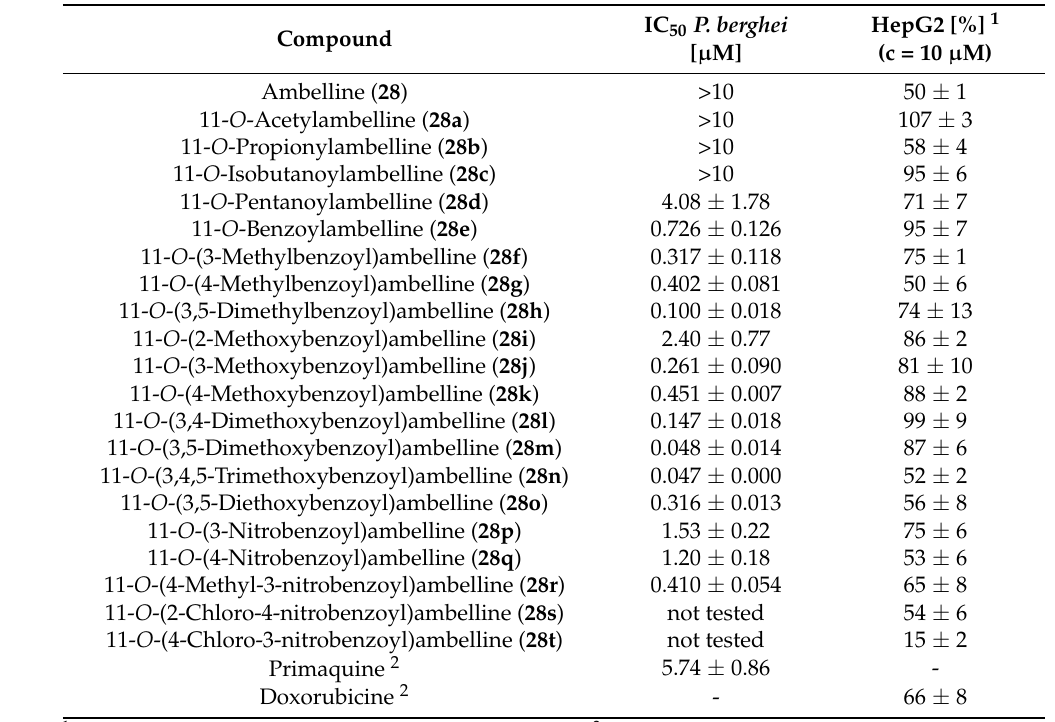
Table 1. Activity of ambelline derivatives against the hepatic stage of malaria caused by P. berghei and their cytotoxic potential.